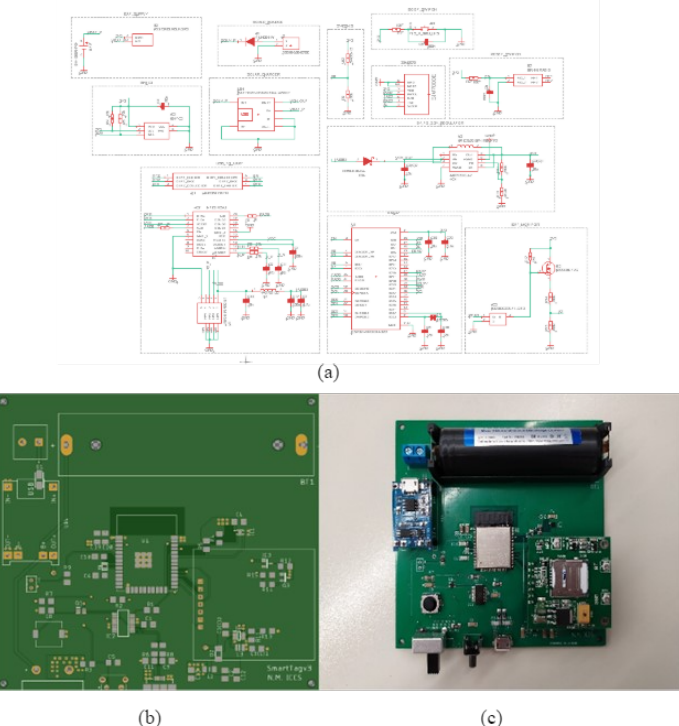
Figure 4. Smart Tag PCB: ( a ) Electronic schematic, ( b ) PCB design and ( c ) PCB assembly.